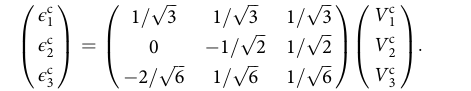
Fig. 2 Various single-electron con fi gurations within the array. a – c Three different double-dot con fi gurations, controlled by compensated voltages V c Numbers indicate the occupation of the three qubit dots (each red dot represents one electron). d Similar to c , but with V c revealing the triple-dot ground-state region. In a – d the top gate is fi xed at